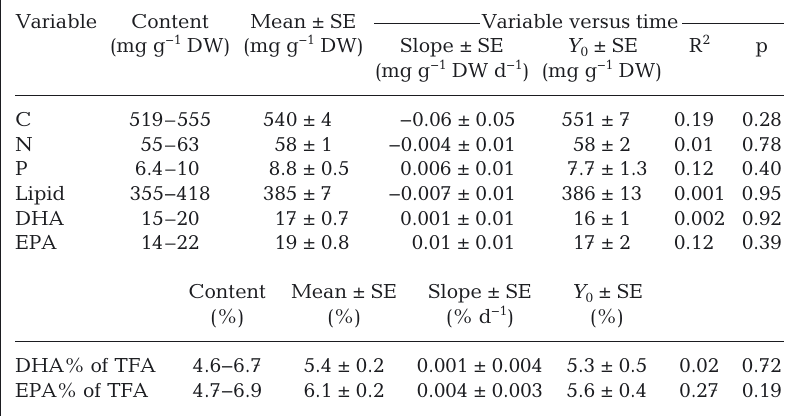
Table 2. Range of chemical content and mean chemical content in feed samples from March to November 2009 (see Fig. 4 for the monthly chemical content), as well as regression coefficients (slope) for chemical content in feed samples as a func - tion of time (day of year). DW: dry weight; DHA: docosahexaenoic acid; EPA: